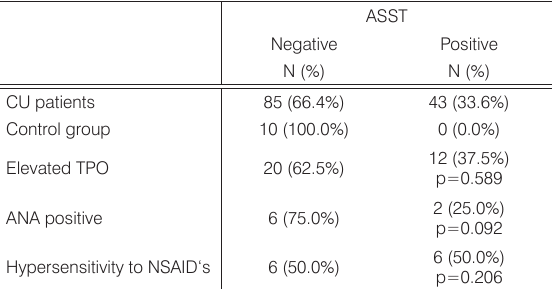
Table 2. ASST positivity and other autoreactivity